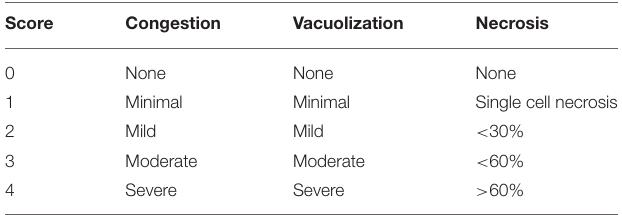
TABLE 1 | Suzuki score for the assessment of liver damage following hepatic